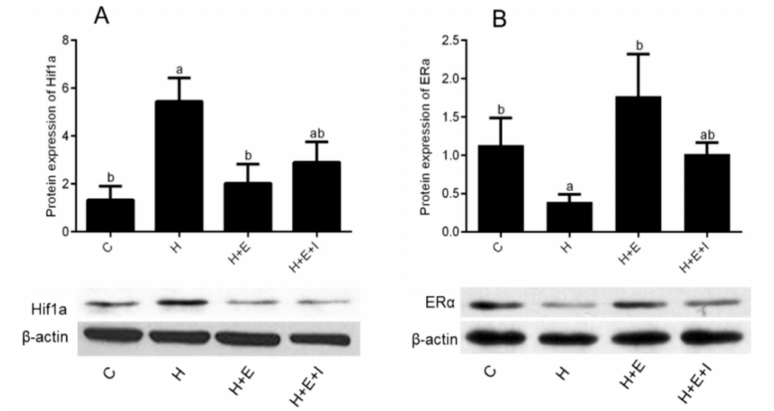
Figure 3. E ff ects of Hypoxia on the expressions of HIF1A ( A ) and ER α ( B ) proteins in bovine early preantral follicles. C, Control; H, Hypoxia; H + E, Hypoxia with E 2 ; H + E + I, Hypoxia with E 2 and ICI. Di ff erent letters (a,b) on the bar means significant di ff erences ( p <